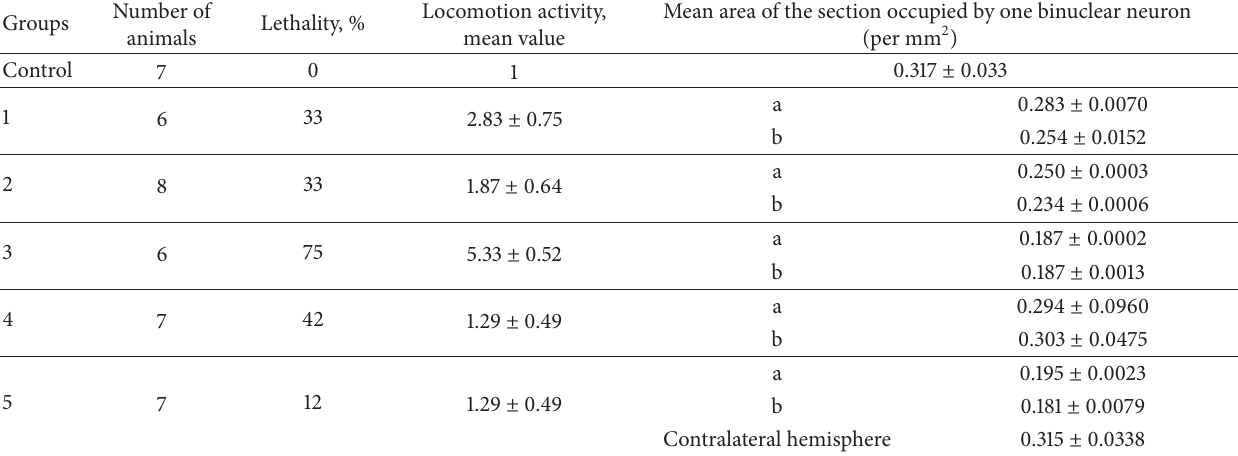
Table 2: Results of the quantitative